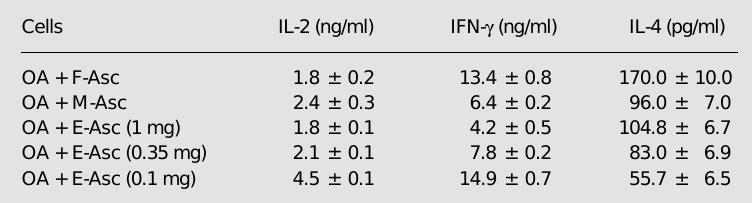
Table 4. Cytokine profile in response to adult worm or egg extract.